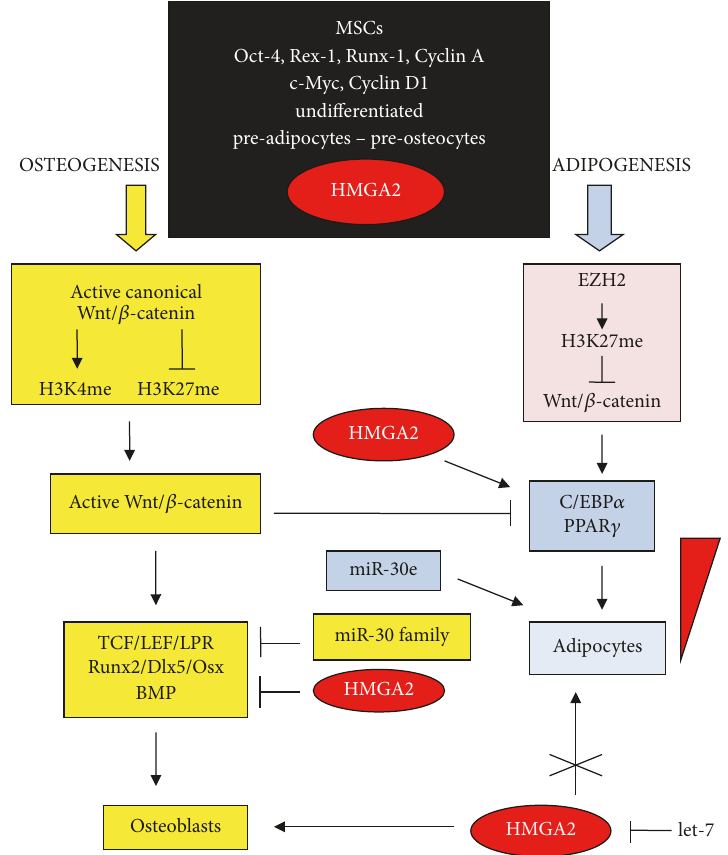
Figure 4: Alternative adipocyte and osteocyte differentiating pathways of MSCs based on EZH2 and Wnt/ 𝛽 -catenin actions. BMP: bone morphogenetic protein; C/EBP: CCAAT/enhancer binding protein; Dlx: distal-less homeobox; LPR: low-density lipoprotein receptor related protein; Osx: Osterix; PPAR 𝛾 : peroxisome proliferator-activated receptor 𝛾 ; Runx: runt-related transcription factor. Symbols are the same as shown in Figure 1.